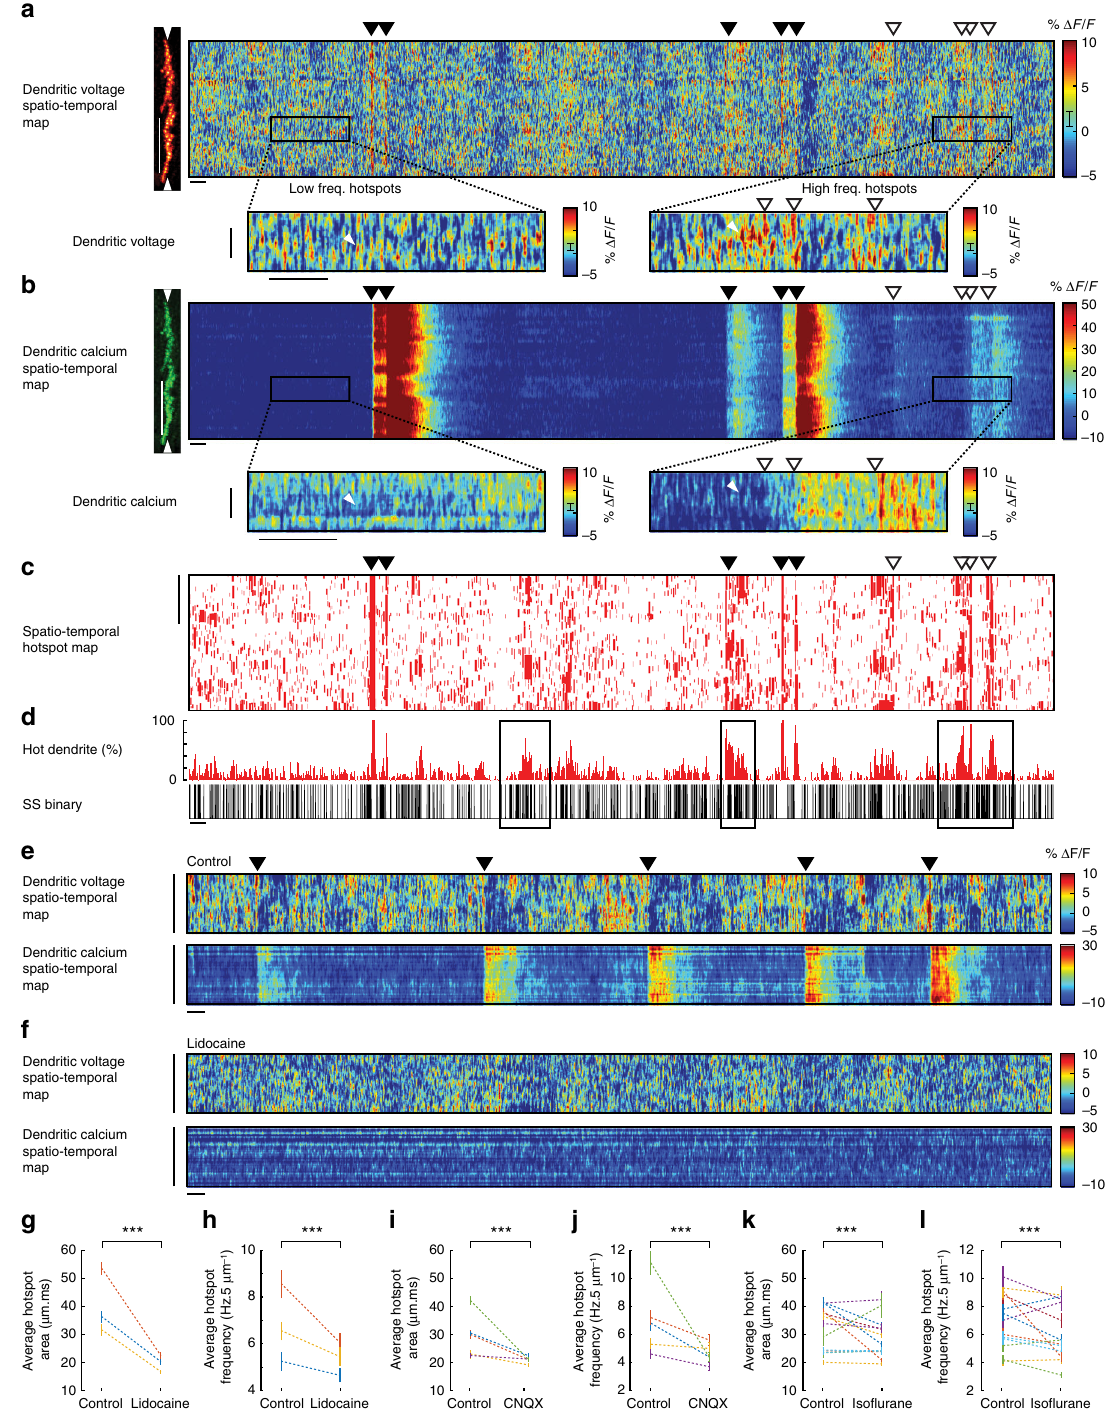
Fig. 5 Voltage imaging reveals the spatiotemporal patterns of subthreshold hotspots in PN spiny dendrites of awake mice. a Spatiotemporal maps for voltage and b calcium recording from PN spiny dendrites. Vertical scale bar 50 μ m; horizontal scale bar 100 ms. Inset boxes show examples of low and high hotspot activity in the voltage recording and the corresponding calcium recording (inset vertical scale bar 5 μ m; horizontal scale bar 100 ms), white triangles indicate single hotspot events detected in the voltage map, but not in the calcium map. c Corresponding hotspot mask (hotspot ROIs from a ) showing spatiotemporal hotspot map. Vertical scale bar 50 μ m. d Percent of hot dendrite (5 ms bins) calculated from ( c ), and corresponding somatic SS binary trace (black bars), black boxes show epochs of high hotspot frequency and high SS frequency. Filled and open triangles throughout indicate DCS and DS events respectively. Horizontal scale bar 100 ms. e Spatiotemporal maps for voltage and calcium during awake (control) conditions and f following application of 0.2% lidocaine. Vertical scale bar 50 μ m. Horizontal scale bar 100 ms. Average hotspot area and frequency in control conditions and following pharmacological manipulation by g , h lidocaine (3PNs), i , j CNQX (5 PNs), and k , l during anaesthesia by iso fl urane (13 PNs), paired two-tailed t test, *** p < 0.001. Bars show mean ±